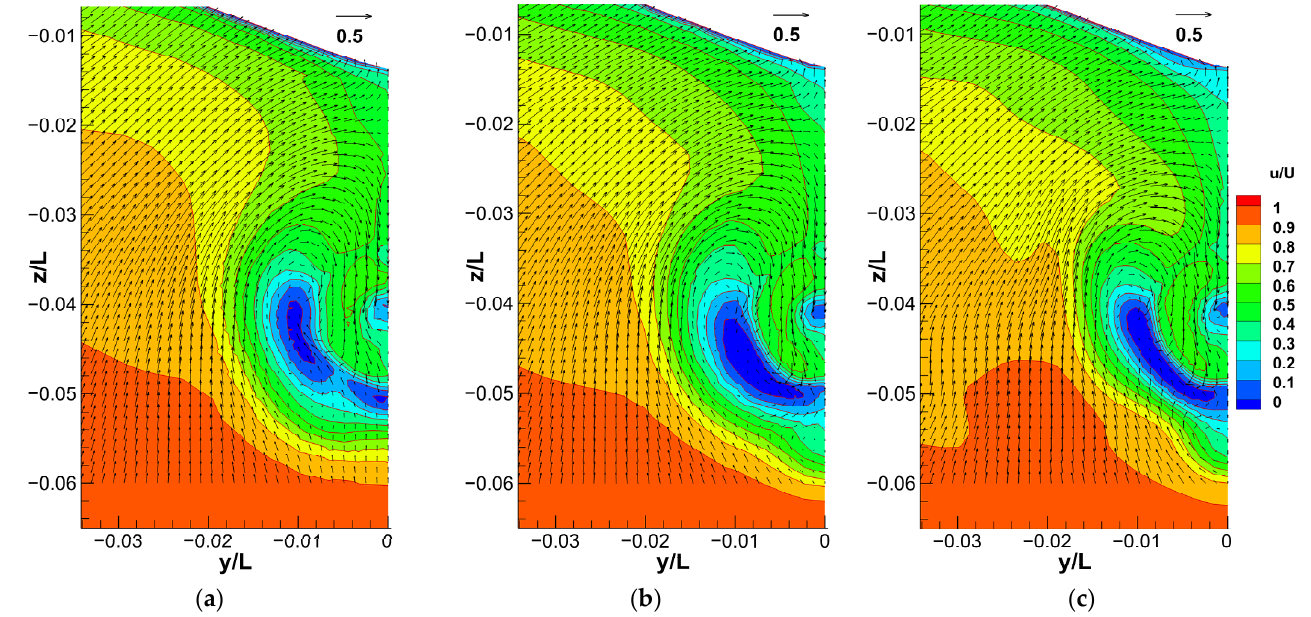
Figure 11. CFD nominal wake velocity field with duct: ( a ) Coarse, ( b ) Medium, ( c ) Fine